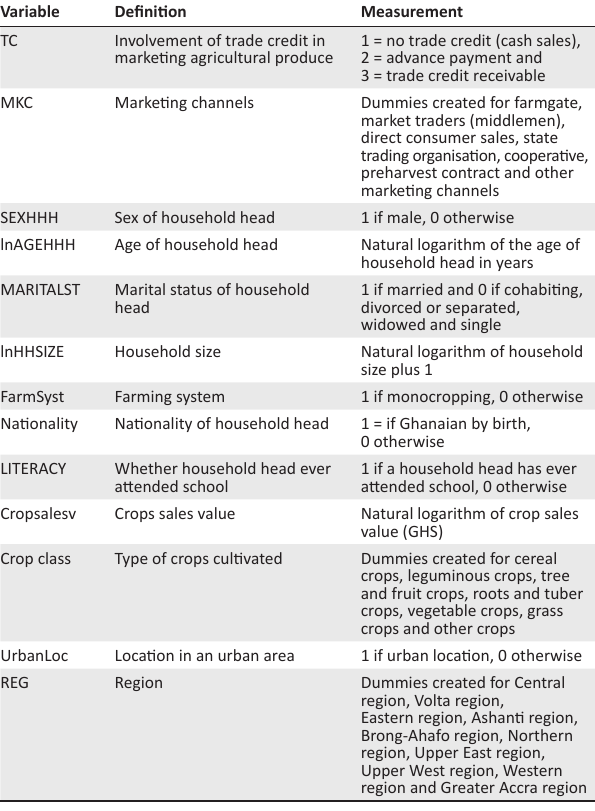
TABLE 1: Variables and measurement.